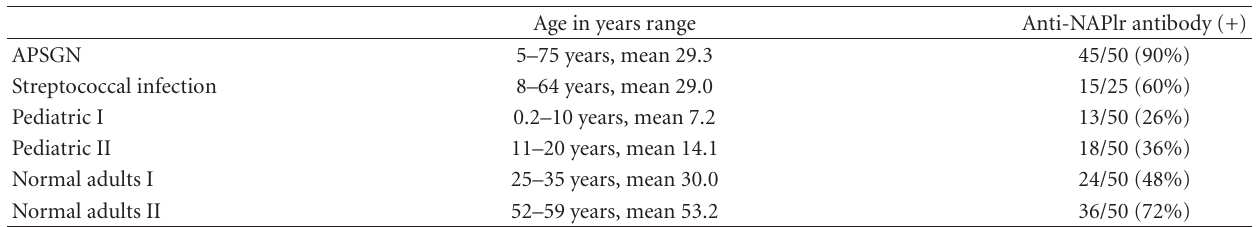
Table 1: Positive rate of serum anti-NAPlr antibody in patients with APSGN, streptococcal infection, pediatric patients, and normal adults.